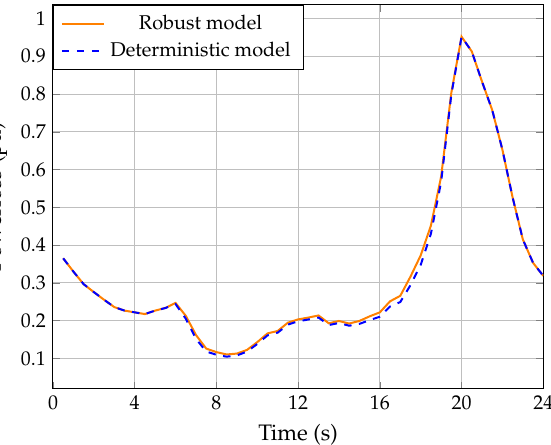
Figure 5. Comparison between the robust and deterministic model of the power losses of the bipolar DC